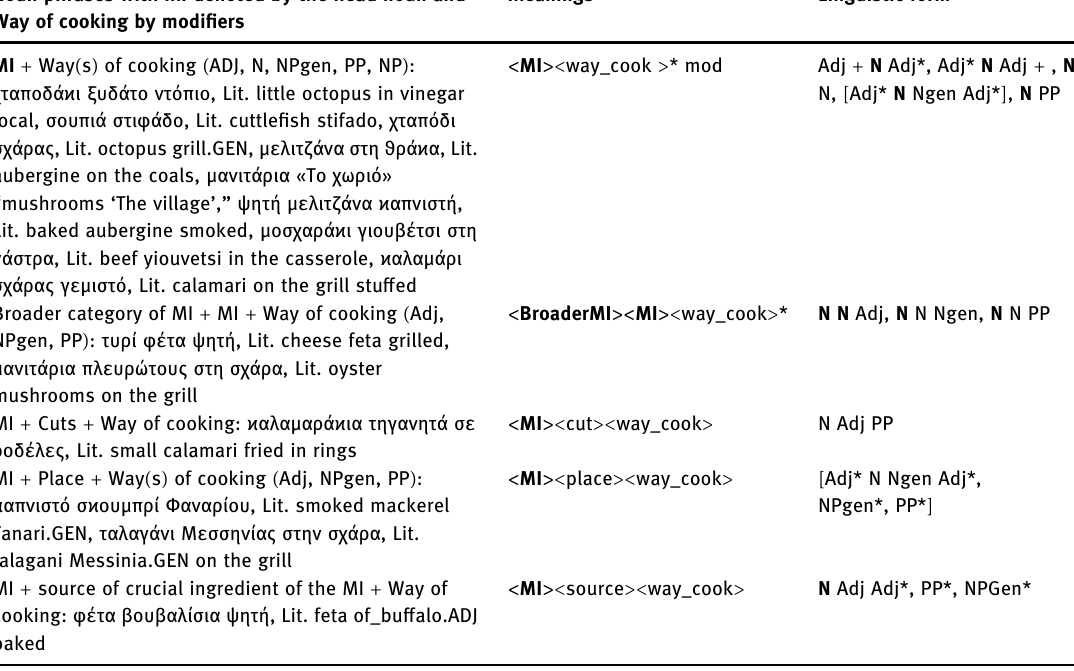
Meanings Linguistic